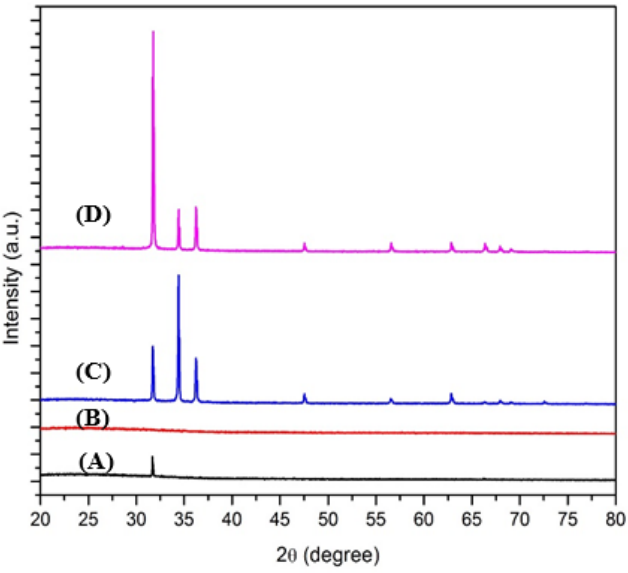
Figure 6. XRD pattern of ( A ) Zn-HMTA seed layer, ( B ) Zn-Pandan seed layer, ( C ) ZnO nanorods on Zn-HMTA seed layer annealed at 500 °C, and ( D ) ZnO microrods on Zn-Pandan seed layer annealed at 400 °C.